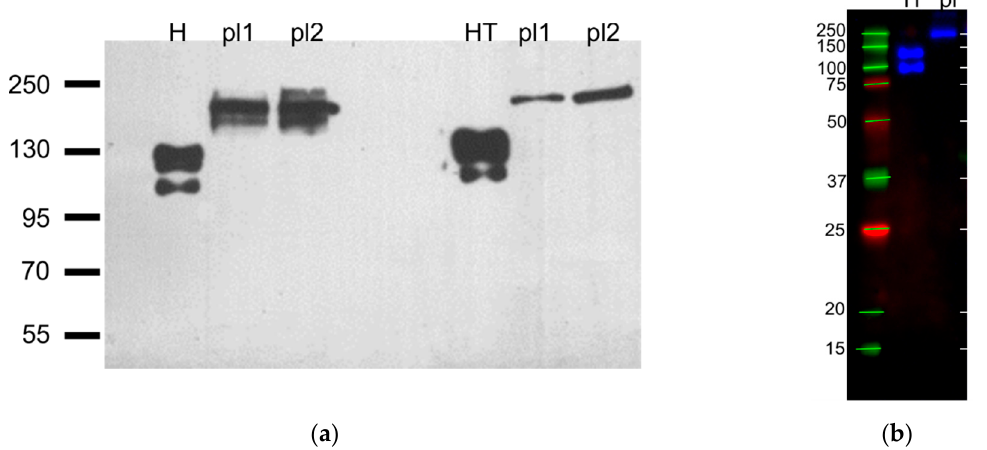
Figure 5. Representative immunoblots against T-cadherin with platelet and positive controls lysates with protein bands standards, n = 5. ( a ) First three lanes were incubated with R&D #AF3264 antibodies, last three lanes were incubated with ProSci #3583 antibodies, H–HUVEC, pl1, pl2—platelets from different donors, HT–HEK293 overexpressing T-cadherin (preparation describe in [31] ) (film), ( b ) H–HUVEC, pl—immunoprecipitate of the platelet lysate (R&D #AF3264, multichannel digital detection).